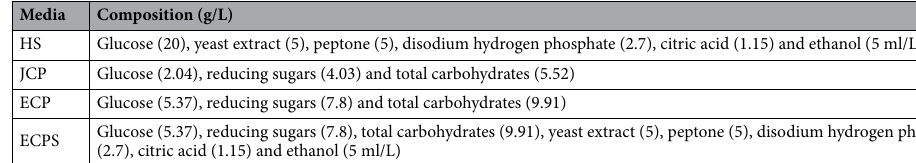
Table 6. Compositions of different media applied for BC production from L. plantarum